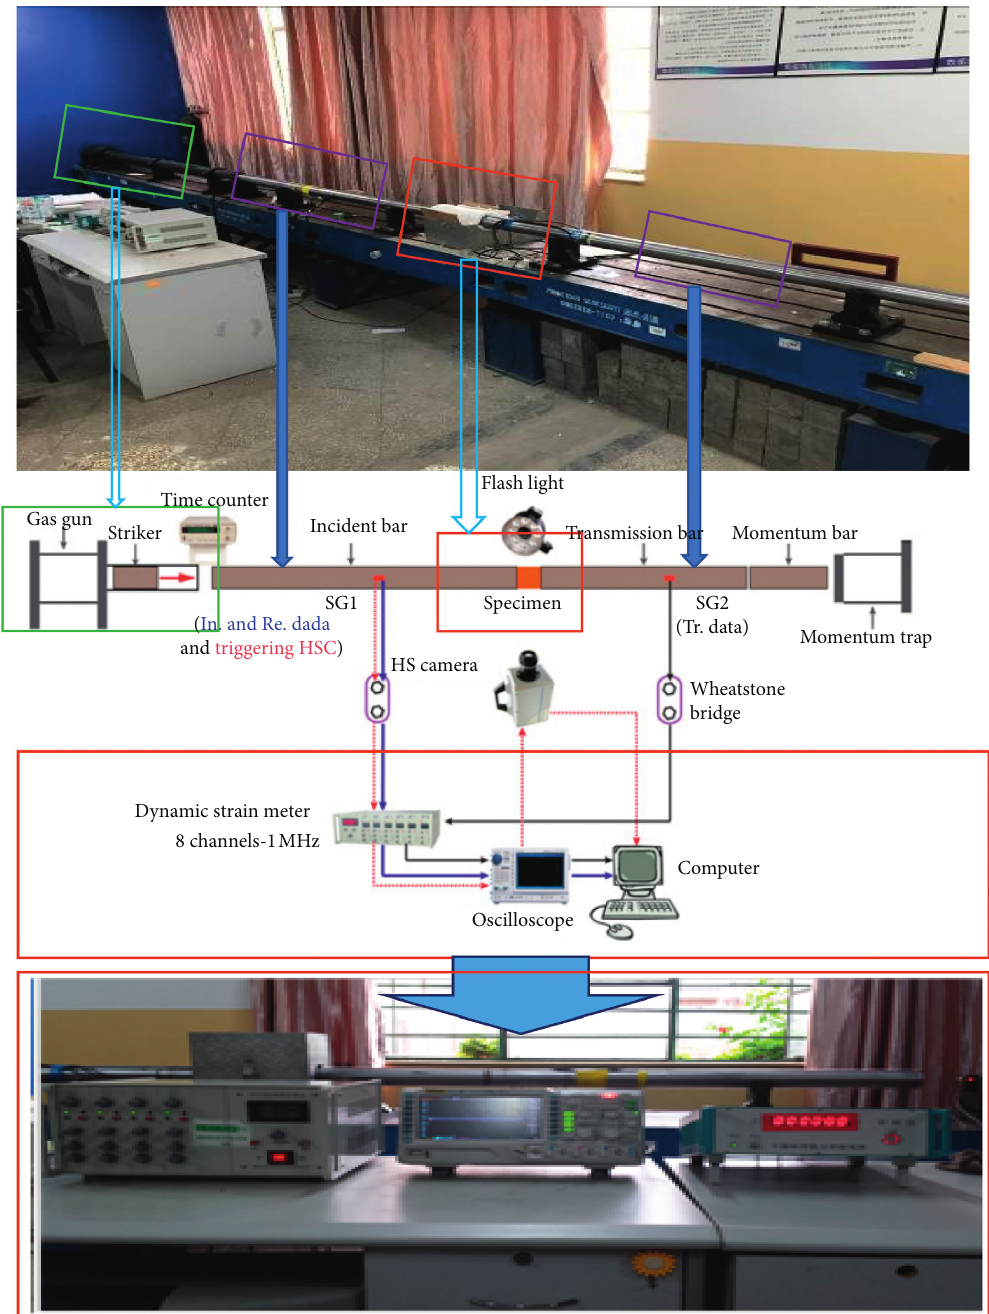
Figure 12: SHPB system (the schematic of the SHPB is adopted from Zhang and Zhao (2013)